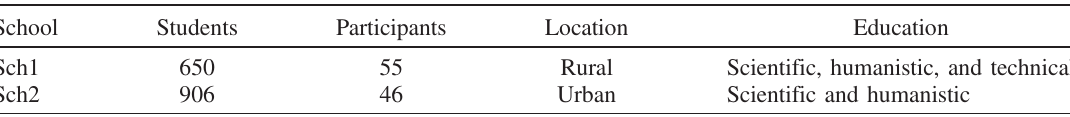
TABLE I. School attributes and characteristics: Exploratory